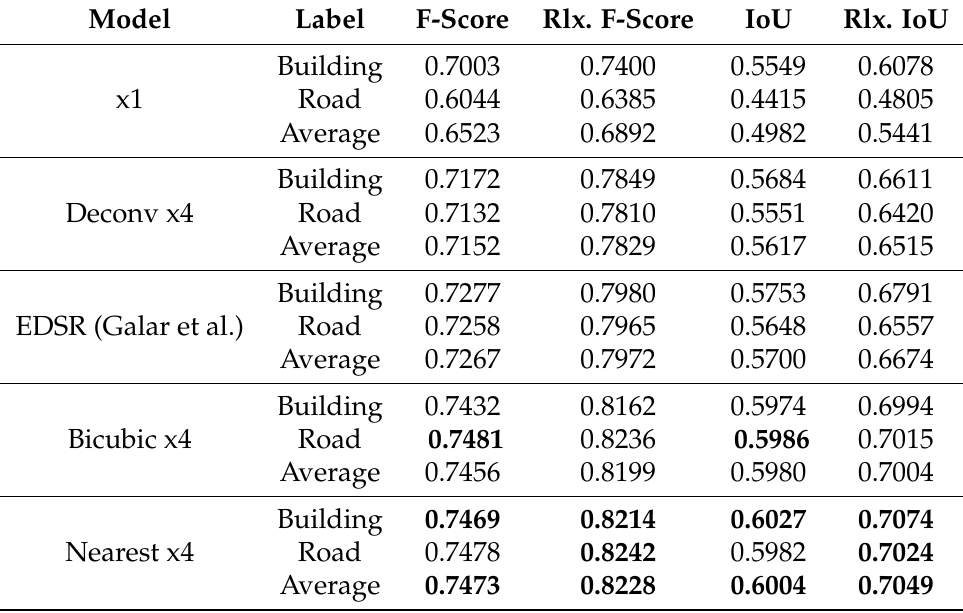
Table 3. Comparison between standard semantic segmentation approach and different ways of enhancing the resolution at the